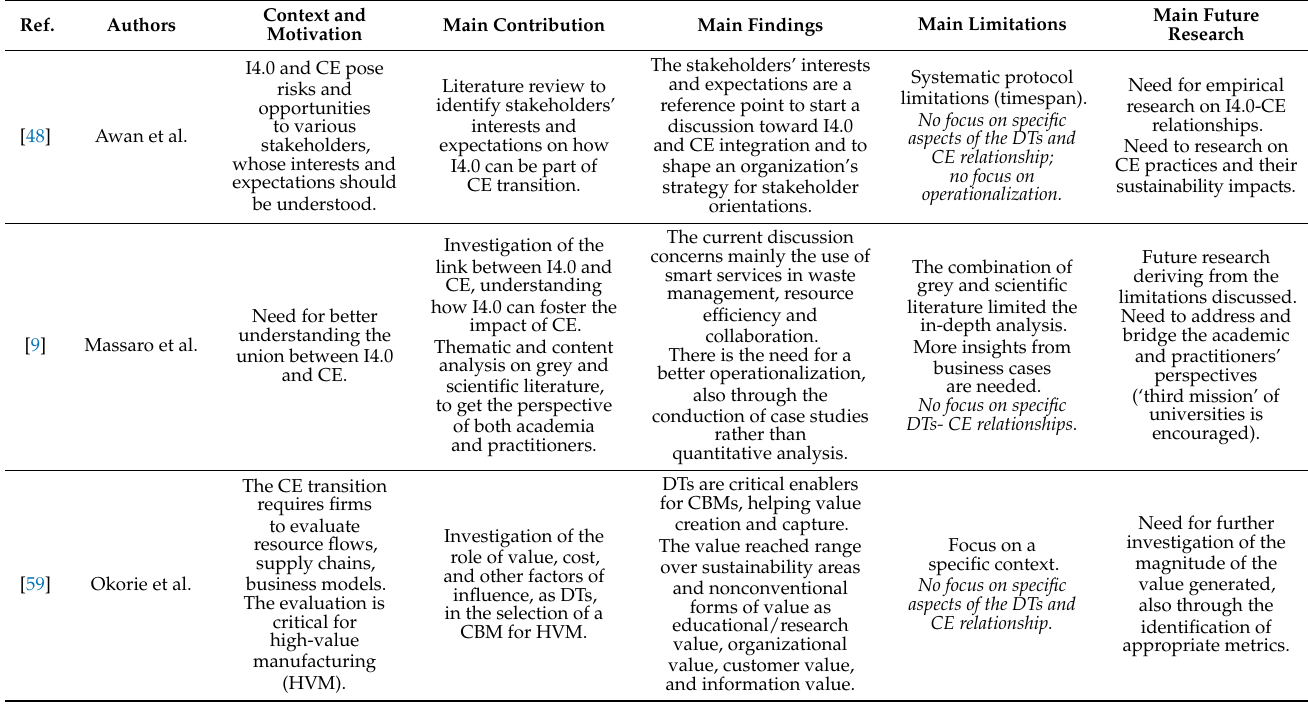
Table 3. In-depth analysis of the content. For the contributions considered for the review analysis, the table reports the following: context and motivation, main contribution, main findings, main limitations and main future research. Limitations in italic refer to limitations related to the specific aim of the present study according to the authors’ perspective.